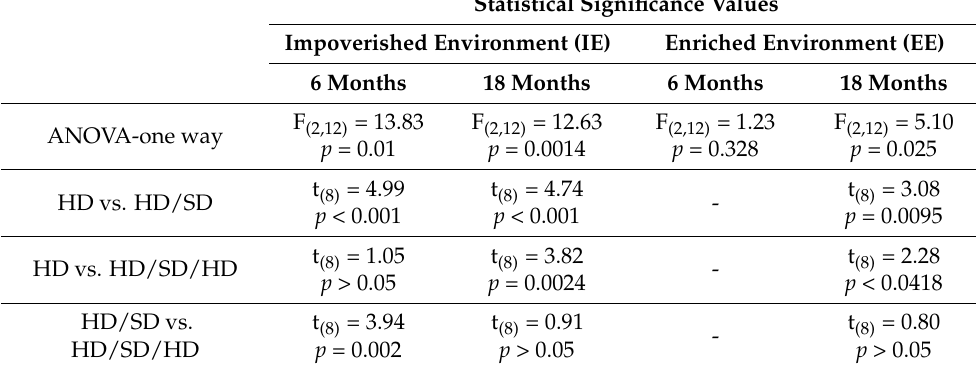
Table 2. Significance values for comparisons between the body weight of animals in each experimental group based on diet regime (HD, HD/SD, and HD/SD/HD), age (6 or 18 months), and both environments (impoverished or